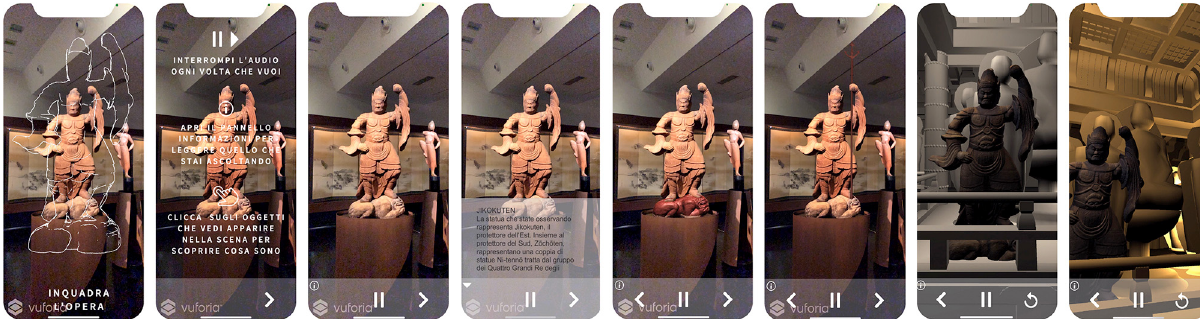
Figure 7 . Screenshot of the AR application created on the two Ni-Tennō statues. Editing: S. Tamantini.